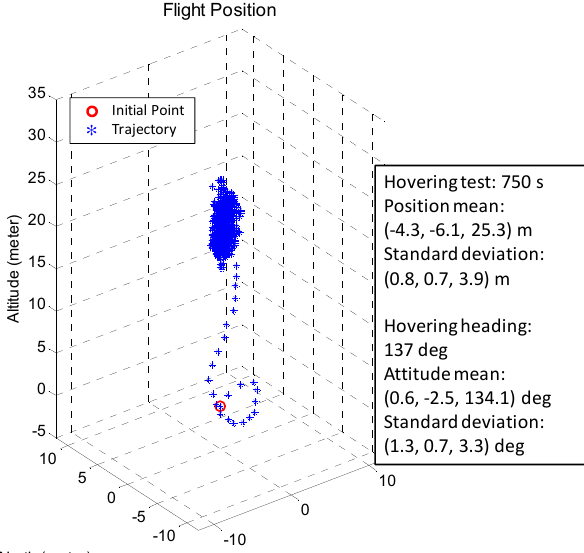
Figure 15. The hovering test result of the FCS under the ideal weather